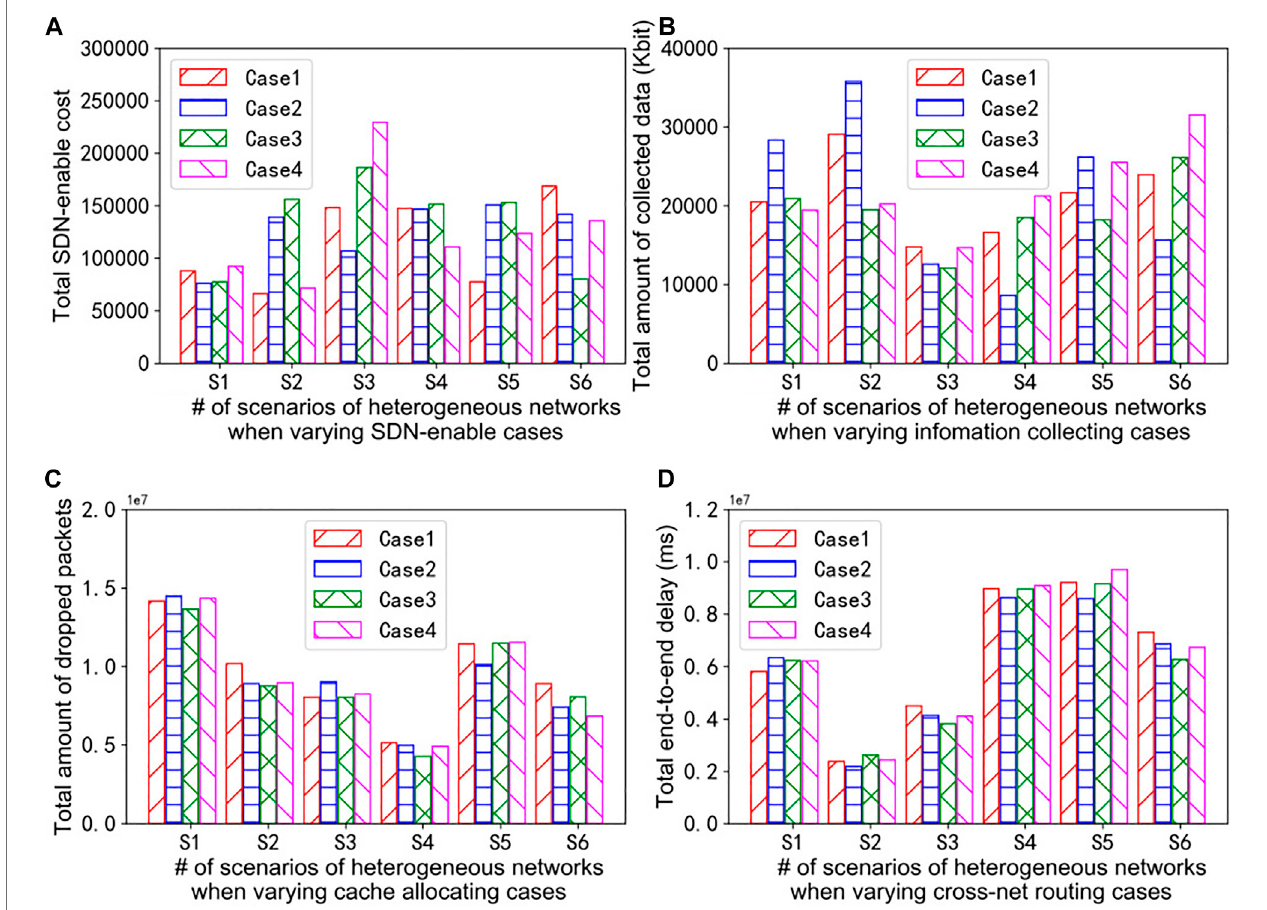
FIGURE 6 | Performance evaluation: (A) the SDN-enable costs; (B) the amount of collected data; (C) the amount of dropped packets; (D) the total end-to- end delay.